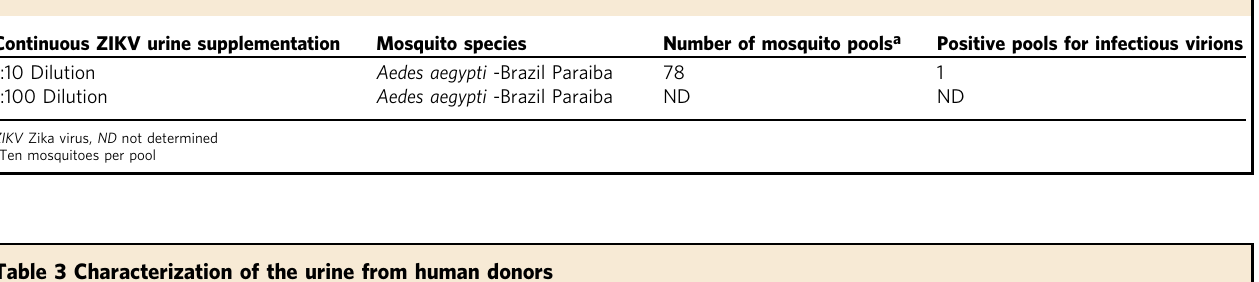
Table 3 Characterization of the urine from human donors Tested factors in donor